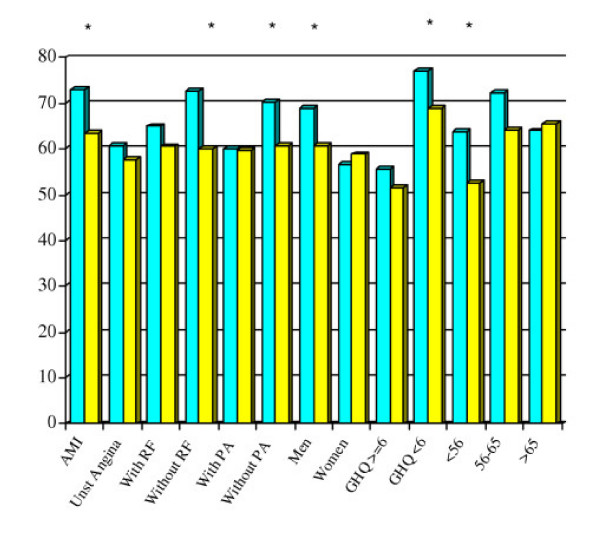
Clinical and demographic variables and vitality dimension score of the SF-36 health questionnaire at baseline and 3 months after discharge from hospital.  (Cont'd)  Baseline.  3 Months.